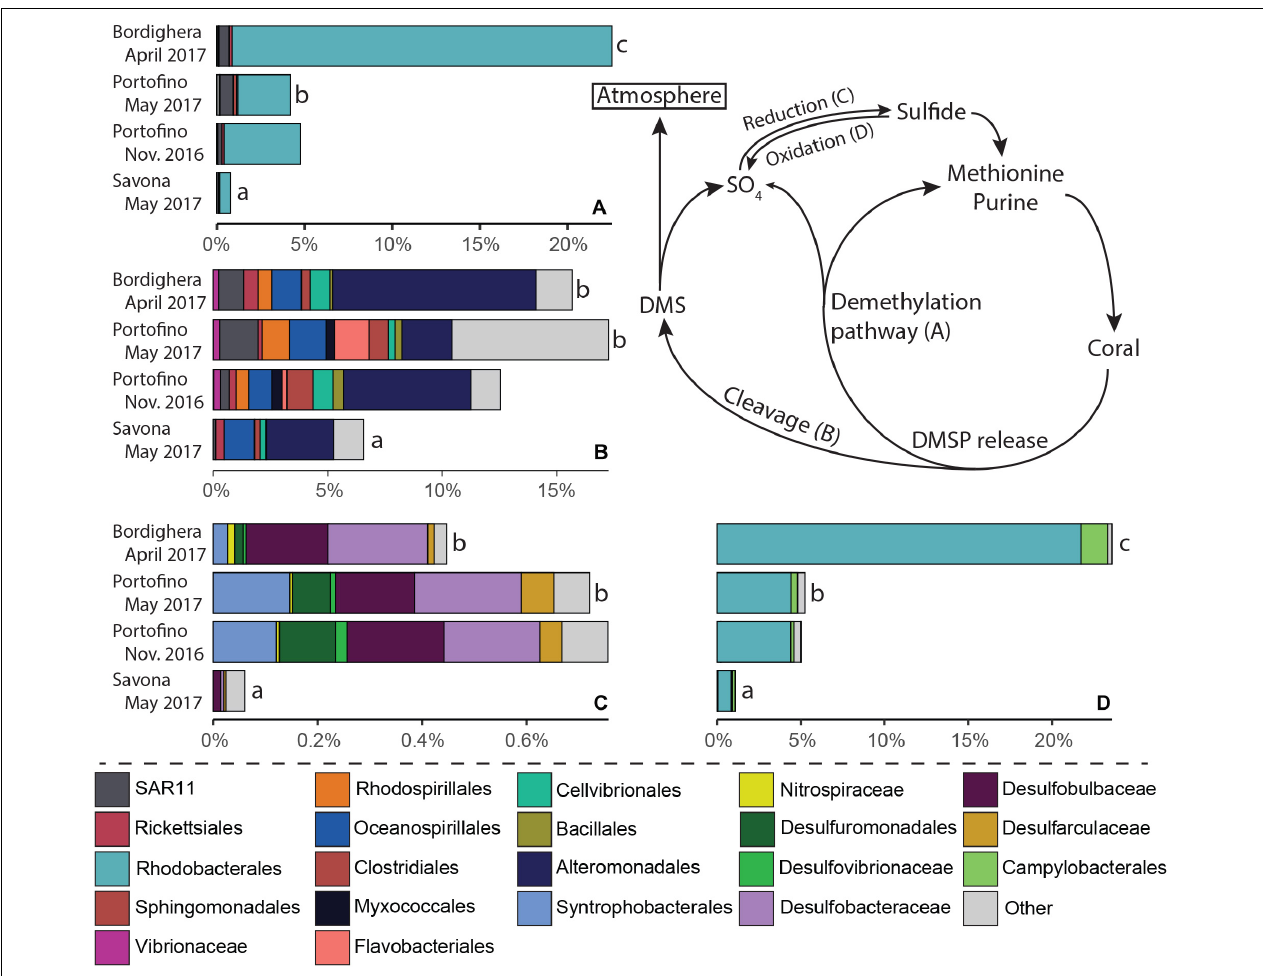
FIGURE 8 | Relative abundance of Antipathella subpinnata- associated bacteria with a putative role in the sulfur cycle. The sulfur cycle consists of four main processes and microbes putatively involved in these processes are presented: (A) DMSP demethylation, (B) DMSP cleavage, (C) sulfate reduction and (D) sulfur oxidation. Differences in the abundance of functional groups between locations are indicated with letters. Taxa with low abundances are combined and indicated in light